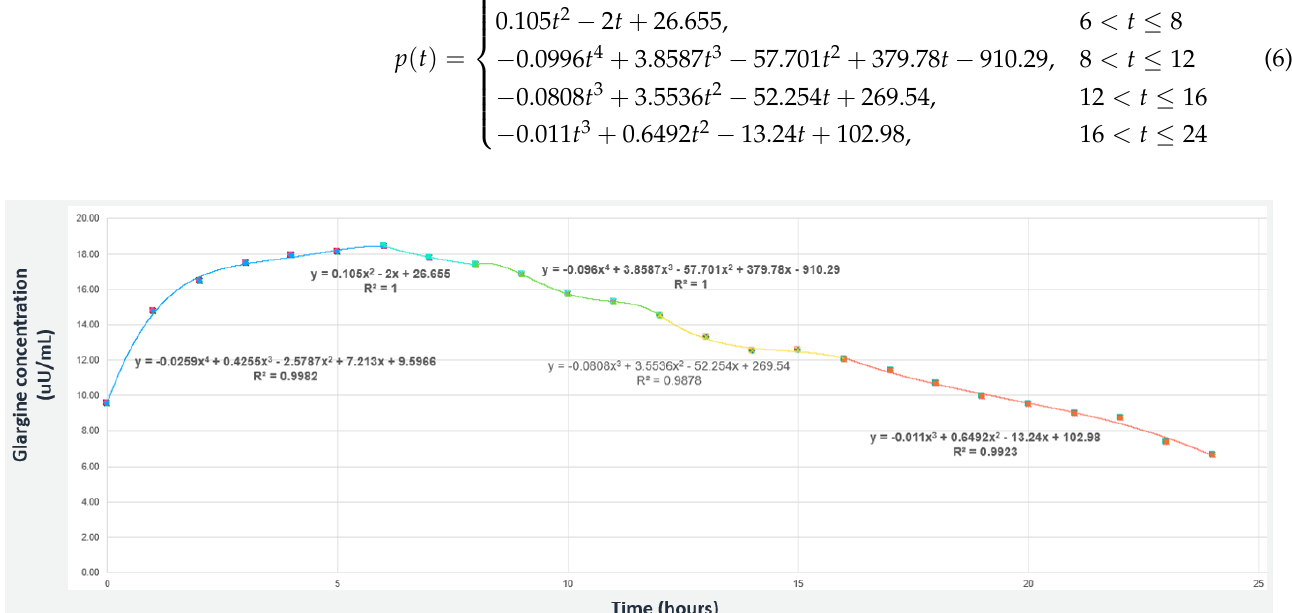
Figure 1. The piecewise polynomial for Glargine insulin (slow-acting) considering 0.36 U/kg